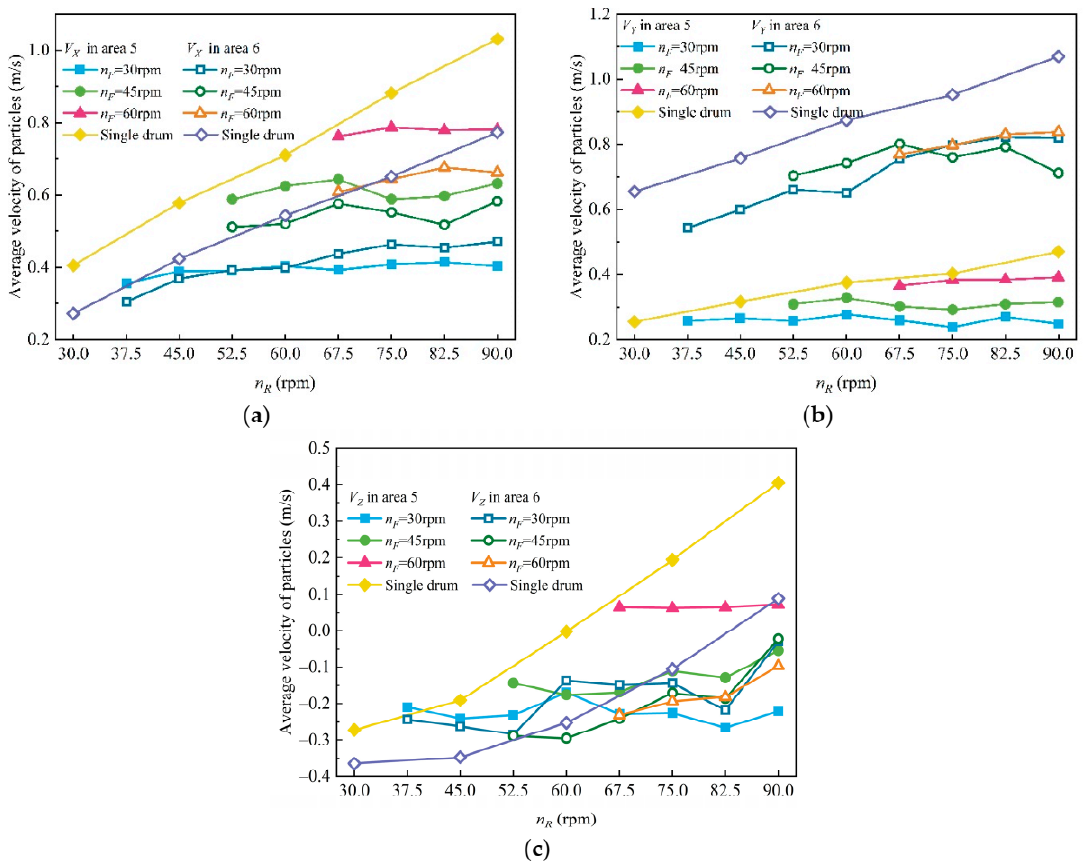
Figure 11. The particles velocities in three-dimension: ( a ) velocity in X direction; ( b ) velocity in Y direction; ( c ) velocity in Z